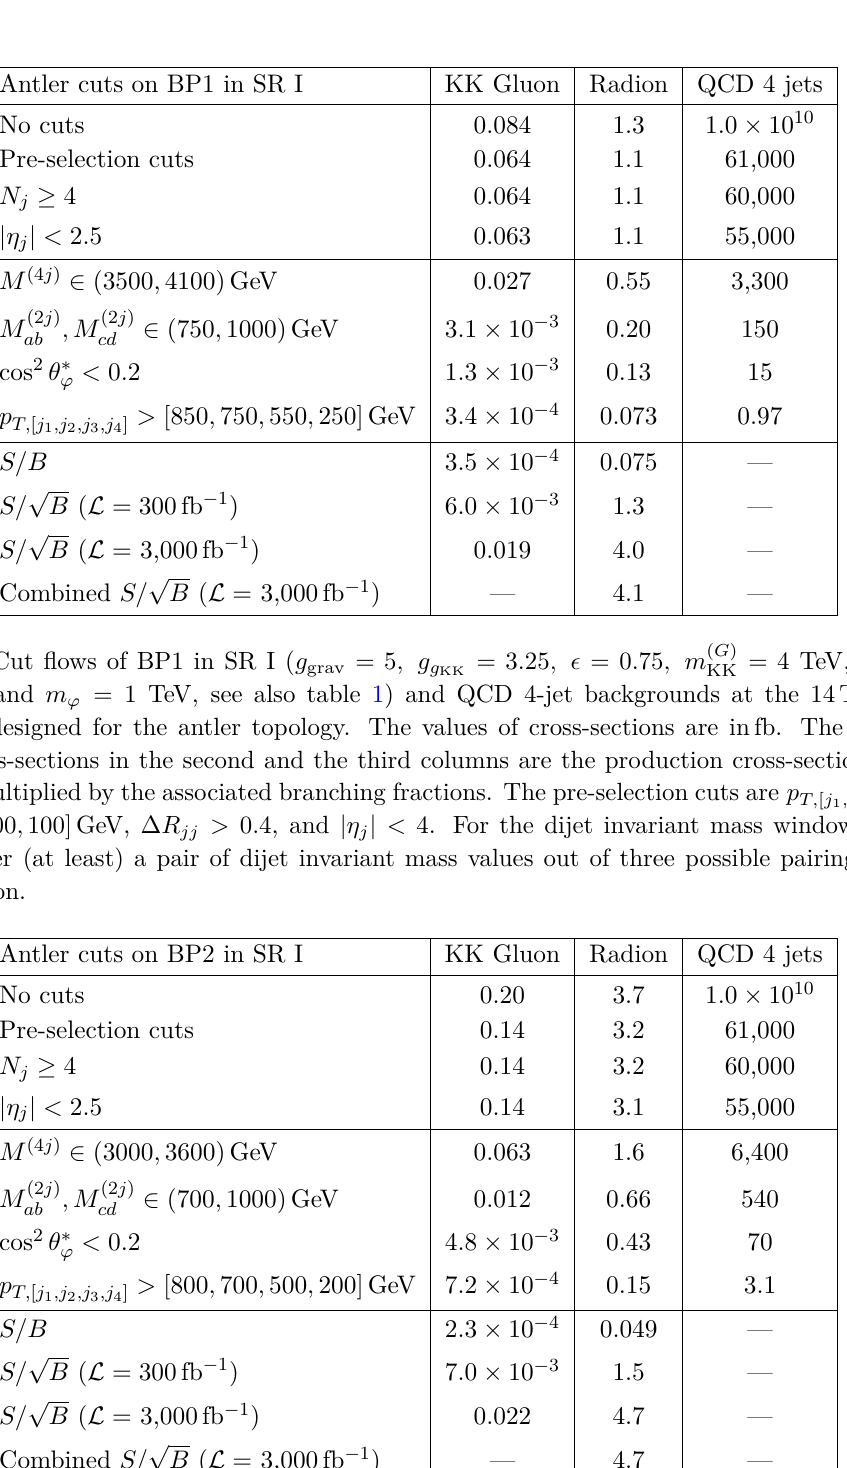
— = 4 , (cid:15) = 1 , m ( G ) = 3 . 5 TeV , m ( g ) = KK KK KK